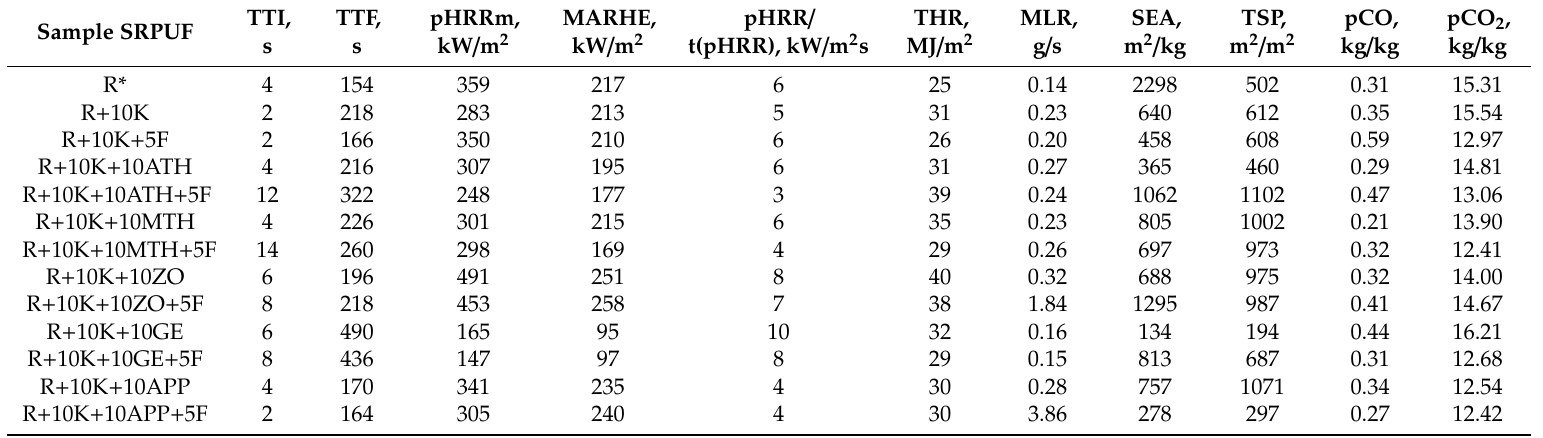
Table 7. Summary of the results obtained on the basis of the flammability analysis carried out with the use of a cone